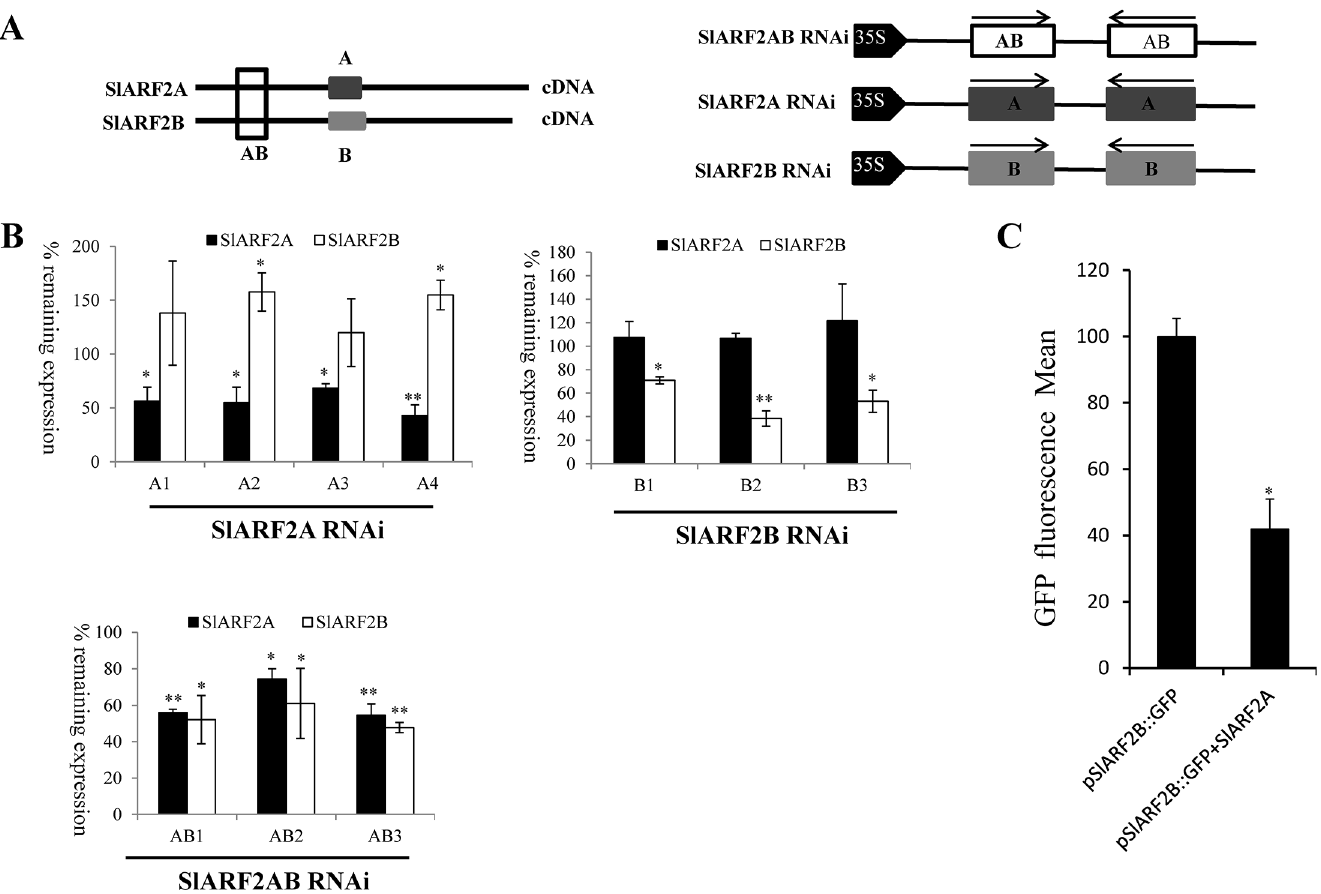
Fig 4. Expression pattern of SlARF2A and SlARF2B in SlARF2 RNAi transgenic lines. (A) SlARF2A-RNAi , SlARF2B-RNAi and SlARF2AB-RNAi constructs. AB = specific fragment in the DBD binding domain for both SlARF2A and SlARF2B used in SlARF2AB-RNAi construct. A = specific fragment in the middle region of SlARF2A used in SlARF2A-RNAi construct, B = specific fragment in the middle region of SlARF2B used in SlARF2B-RNAi construct. (B) transcript levels of SlARF2A and SlARF2B in RNAi transgenic lines analyzed by quantitative RT-PCR. Expression of SlARF2A / SlARF2B in wild type was taken as reference (relative mRNA level 100%) and the SlActin gene as an internal control. % remaining expression of SlARF2A and SlARF2B transcript levels relative to the reference. Error bars mean ± SD of three biological replicates. Stars indicate a statistical significance (p < 0.05) using Student ’ s t-test. (C) SlARF2A negatively regulates the activity of SlARF2B promoter. Tobacco protoplasts were transformed either with the reporter construct (pSlARF2B::GFP) alone or with both the reporter and effector constructs (35S-SlARF2A) and GFP fluorescence was measured 16 h after transfection. Effector construct lacking SlARF2A was used as control for the co-transfection experiments. Transformations were performed in triplicate. Mean fluorescence is indicated in arbitrary unit (a.u.) ± standard error. Stars indicate a statistical significance (Student ’ s t-test): * p-value < 0.05, ** p-value < 0.01.